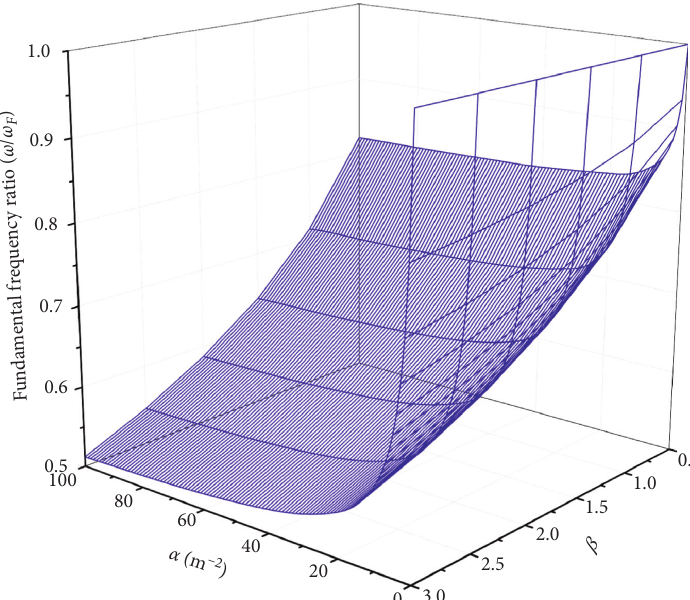
Figure 9: ω / ω F of SCCCB with different α and β